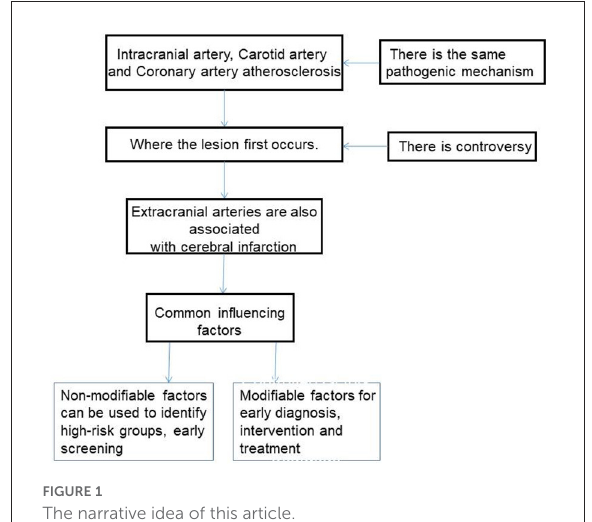
FIGURE1 The narrative idea of this